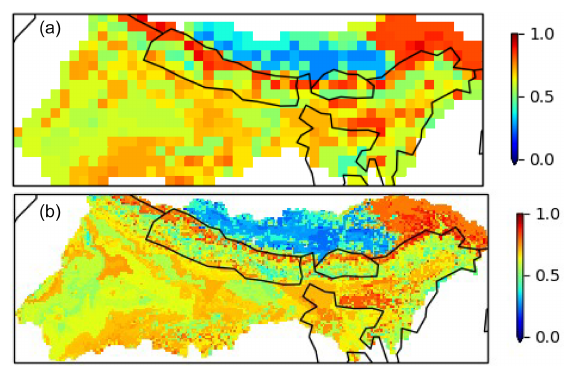
Figure 7. Mean of NSE scores from the three best donor catchments transferred by regionalization to each grid cell. The NSE values were calculated using observed streamflow from each donor catch- ment (all outside the GBM) and hence should not be interpreted as the model performance in each grid cell of the GBM region. Panel (a) is 0.5 ◦ and (b) is 0.1 ◦ horizontal resolution. Note: plots are for simulations using FUSE structure 902, forced by MSWEP precipi- tation. A value of 1 indicates perfect agreement between the model and observations (in the donor catchments), while a value of 0 in- dicates that the model has no more skill than using the mean dis-